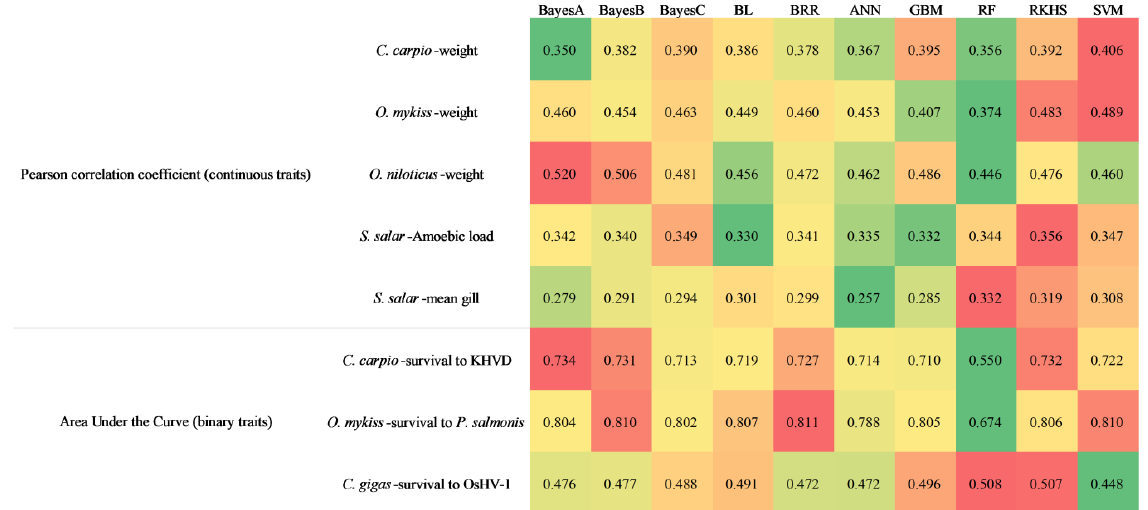
Figure 1. Prediction accuracies of the ten genomic-prediction algorithms analyzing various traits in five aquaculture species. The Pearson correlation coefficient and area under the curve (AUC) were used to evaluate the prediction accuracy of algorithms in each of the traits. Green denotes the lowest prediction accuracy in each trait, while red denotes the highest prediction accuracy.